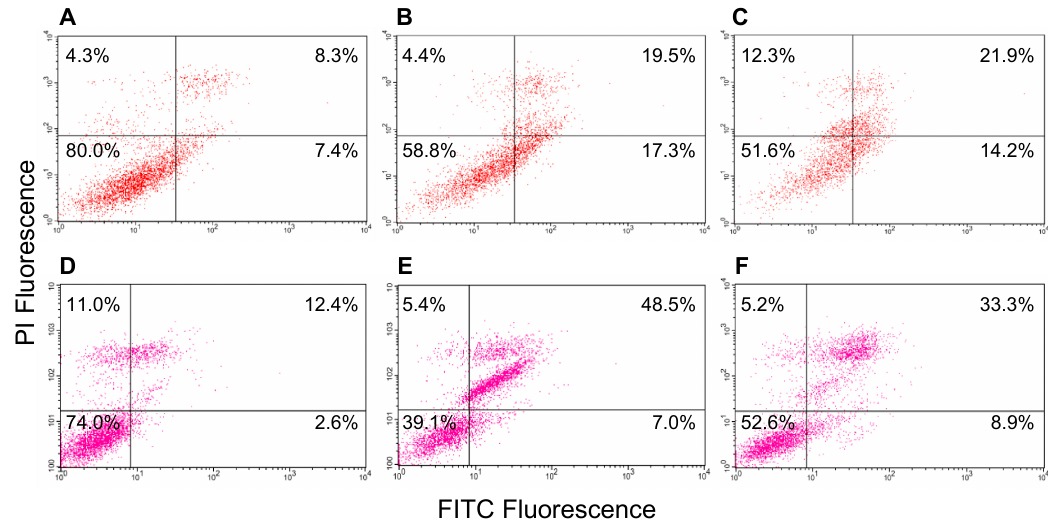
Figure 7. Apoptosis analysis with annexin V-FITC/PI double staining on MCF-7 cells treated for 96 h with ( A , D ) control, AS1411-GT-5 ′ tr at ( B ) 1 µM and ( E ) 10 µM, and AS1411-GT at ( C ) 1 µM and ( F ) 10 µM. For all panels: upper left quadrants, necrotic cells; upper right, advanced apoptotic cells; lower left, viable cells; lower right, early apoptotic cells. These results are representative of three independent experiments.